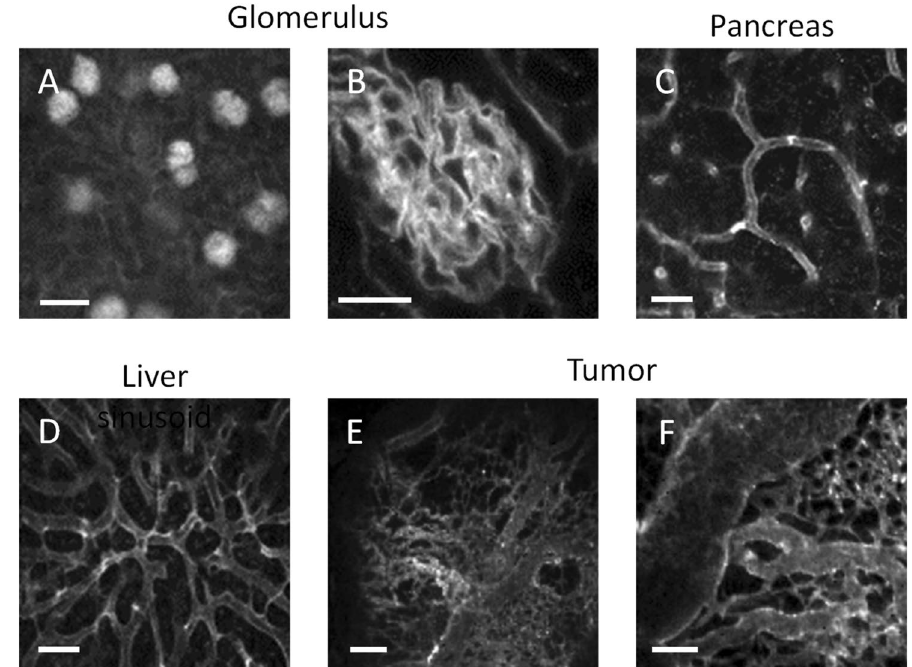
Figure 6. Phosphorescence intensity images of kidney ( A ), glomerulus ( B ), liver sinusoids ( C ), and pancreas ( D ) in living mice administrated BTQ-R 12 (100 nmol) via the tail vein under anesthesia. ( E , F ) Phosphorescence intensity images of tumor vascular networks. λ exc : 488 nm, λ em : > 590 nm. Scale bar: 100 μm in ( A ), 20 μm in ( B ), 50 μm in ( C ), 50 μm in ( D ), 500 μm in ( E ), 100 μm in ( F